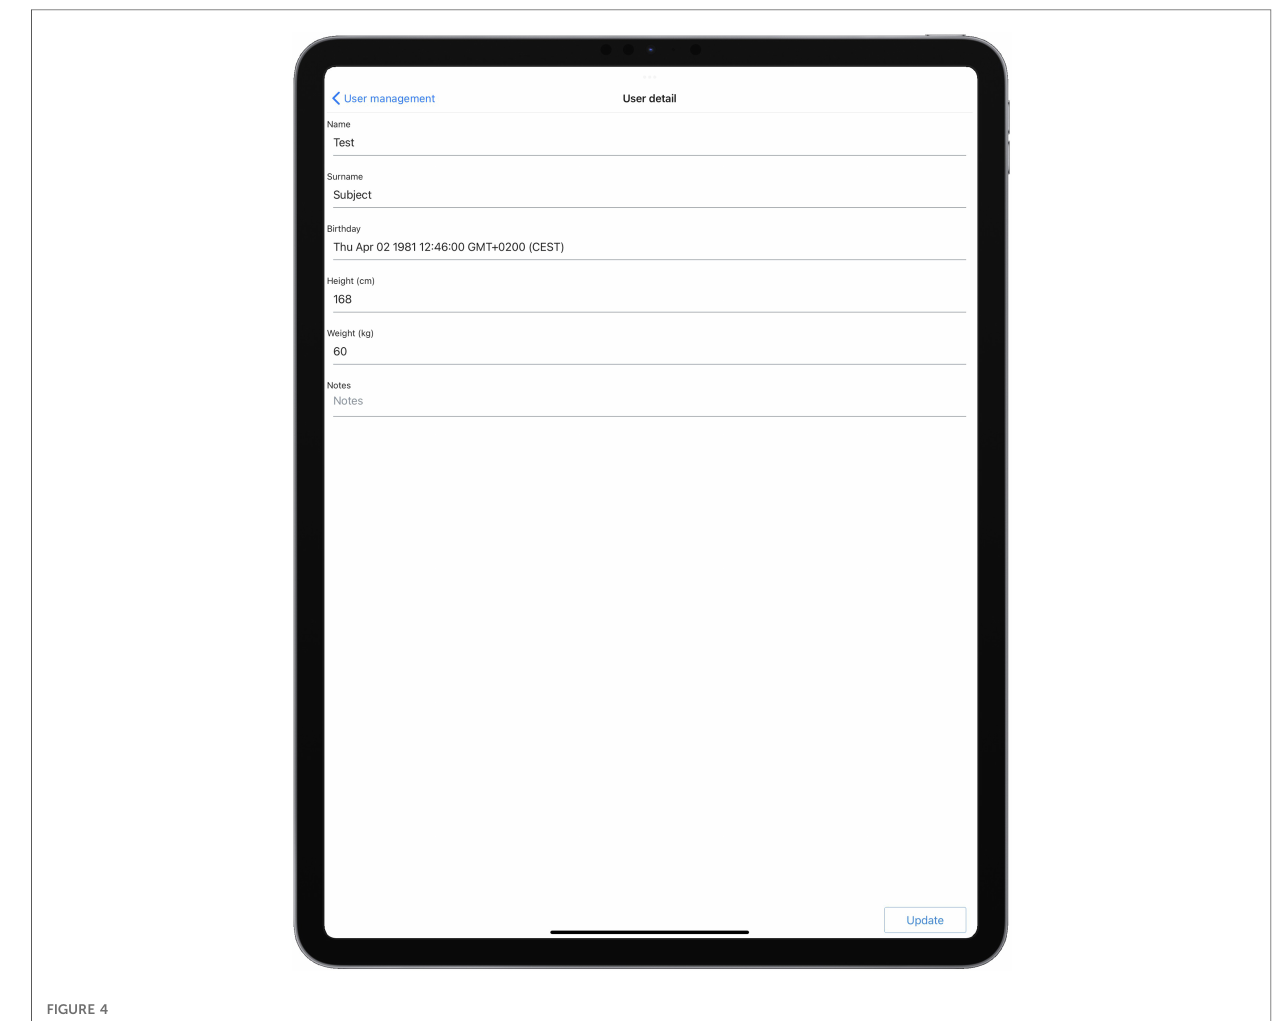
FIGURE 4 User Detail environment. User data de fi ned in this environment can be attached to a